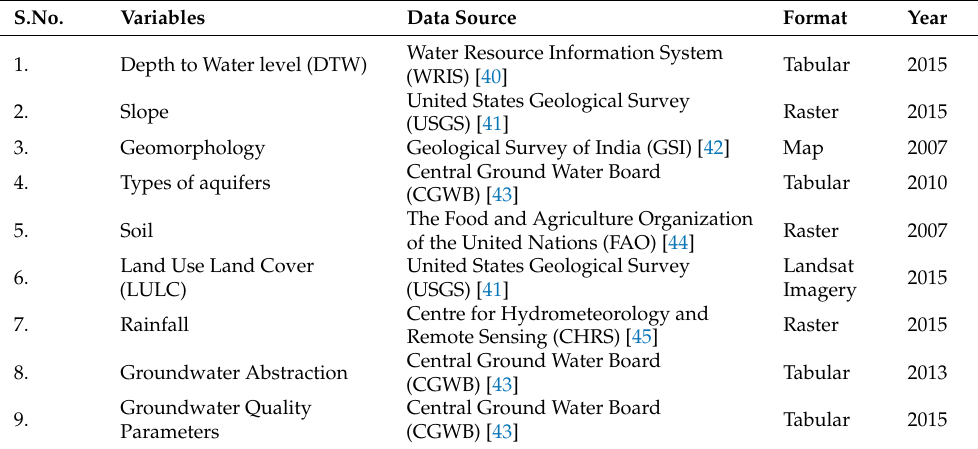
Table 1. Selected variables and the data